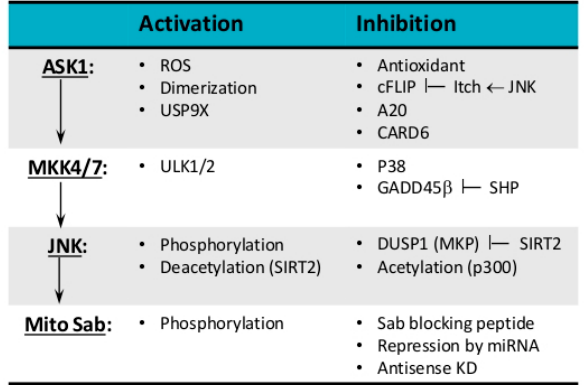
Figure 2. Modulation of JNK activation loop. JNK-SAB-ROS activation loop can be modulated at all level of MAP kinase cascade through phosphorylation by upstream kinase, dephosphorylation by phosphatase, acetylation by sirtuins, deacetylation by p300, protein stabilization by deubiquitinating enzymes, and protein degradation by ubiquitinating enzymes.